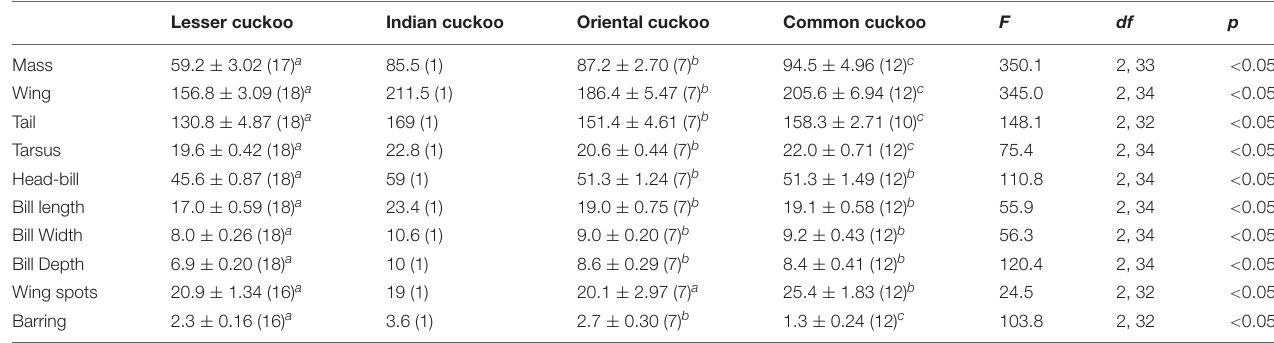
TABLE 2 | Mean ( ± s.d.) body size, number of inner wing spots, and thickness of underpart barring of the four Cuculus female